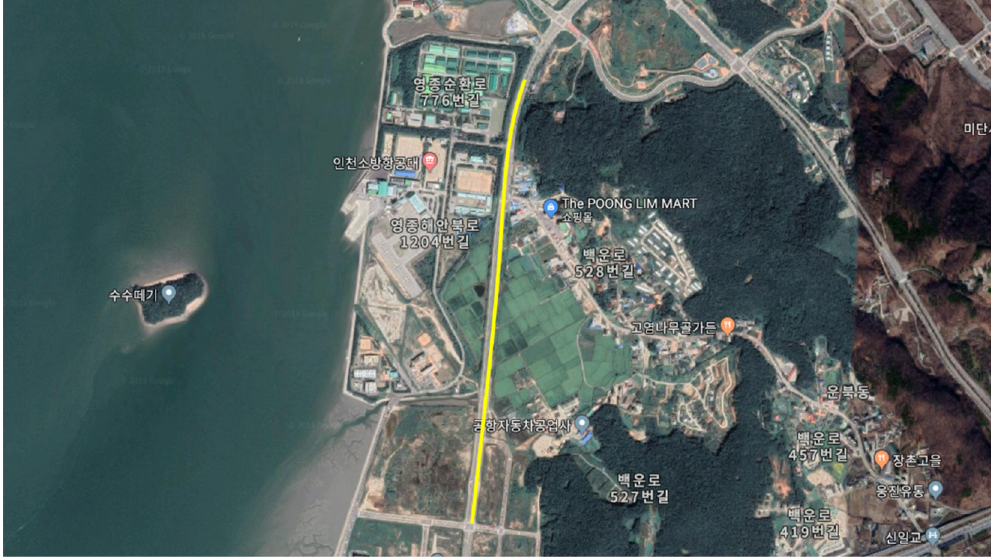
Figure 18. Test route for validation of online learning algorithm.